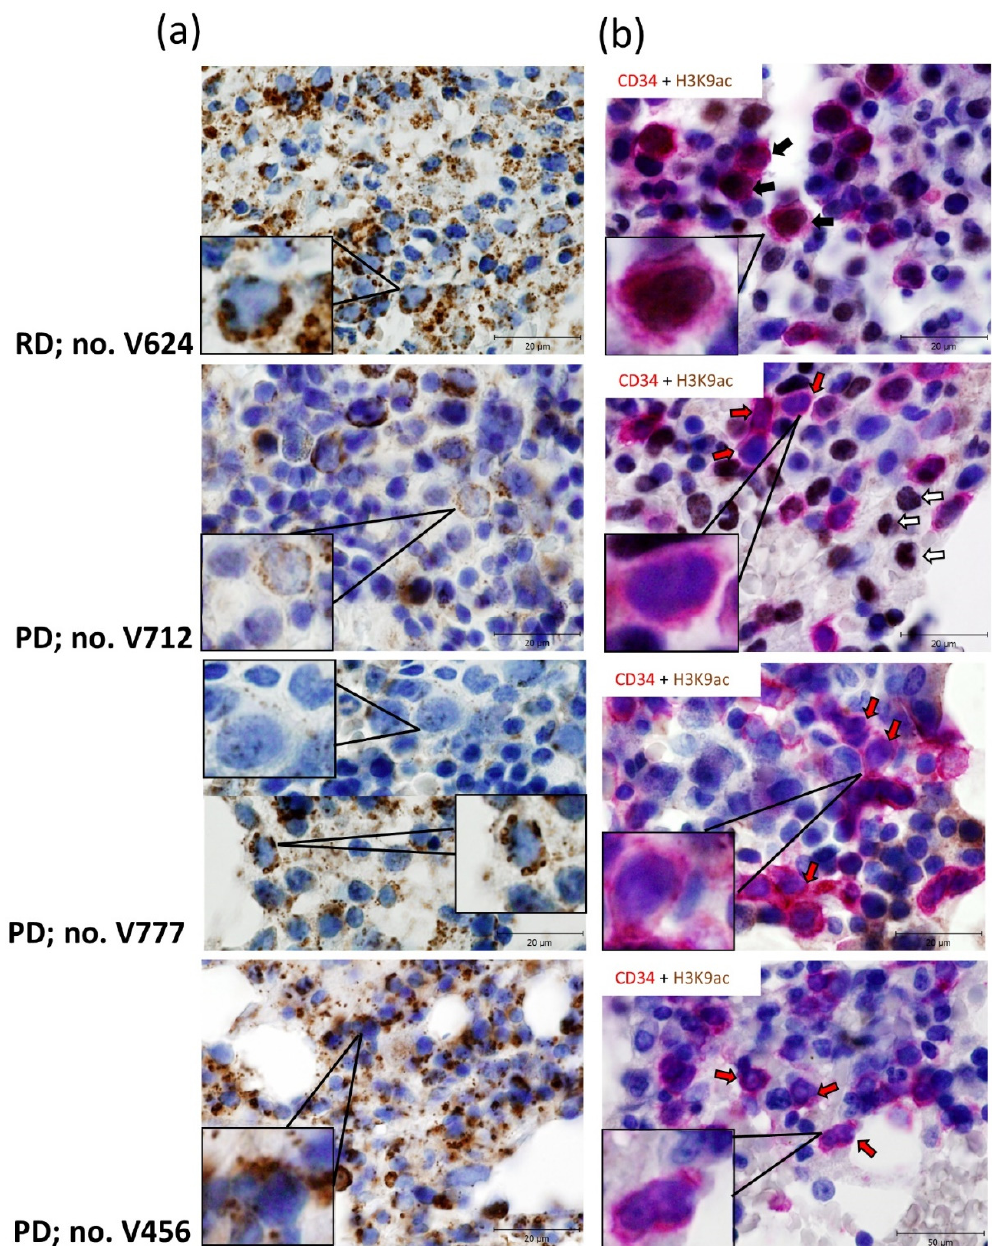
Figure 5. Representative IHC staining for IDH2 ( a ) and CD34 with histone H3 lysine 9 acetylation (H3K9ac) ( b ) in BM trephine biopsies of AZA pre-treatment MDS/AML-MRC patients. ( a ) Mitochondrial staining for IDH2 (brown) with hematoxylin nuclear counterstains (blue) in BM trephine biopsies from RD vs. PD patients. Upper panel: Strong mitochondrial staining for IDH2 in RD patient no. V624. Middle panels: Rare/weak IDH2 staining of PD patient no. V712; alternating clusters of either positively or negatively stained cells in PD patient no. V777. Lower panel: Intermediate/strong mitochondrial staining for IDH2 in PD patient no. V456. See Supplementary Table S1 for patients’ details. Scale bars, 20 µ m. ( b ) Sequential double staining for CD34 (first primary antibody, visualized with the Envision FLEX HRP Magenta Substrate Chromogen System (red)) and H3K9ac (second primary antibody, visualized with DAB chromogen (brown)), with hematoxylin nuclear counterstains (blue). Individual sections show cells with specific membranous and diffuse cytoplasmic staining for CD34 [68] and nuclear H3K9ac staining. The arrows indicate examples of CD34 and H3K9ac double-positive cells (black arrows), CD34 positive cells (red arrows) and H3K9ac positive cells (white arrows). Upper panel: Co-expression of CD34 and H3K9ac in RD patient no. V624. Middle and lower panels: Distinct cells with immature nuclei stain for CD34 and with less immature nuclei for H3K9ac in three PD patients no. V712, V777, V456. See Supplementary Table S1 for patients’ details. Scale bars, 20 μ m.